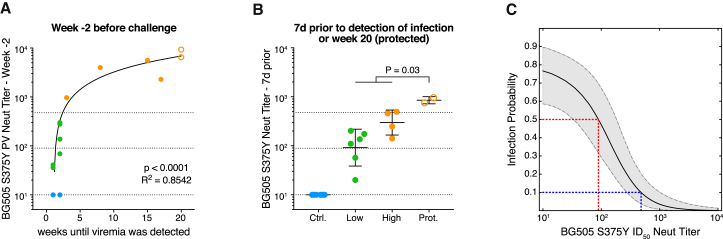
Protection Is Associated with Serum nAb Titers Greater than ∼1:500(A) Correlation of BG505 S375Y pseudovirus ID50 nAb titers at week −2 with the number of weeks until viremia was detected.(B) BG505 S375Y pseudovirus ID50 nAb titers of control (Ctrl.), low nAb titer (Low), and high nAb titer (High) animals 7 days before detection of viral load in the blood and at week 20 for protected (Prot.) animals that showed sterilizing protection throughout the study. All nAb titers were measured in TZM-bl assays. Shown are geometric mean titers with geometric standard deviations. Correlations were calculated using Spearman correlation tests, comparisons between groups were calculated using Mann-Whitney U tests. Horizontal lines indicate 50% and 90% protective nAb titers as defined in (C).(C) The 5%, median, and 95% credible intervals (CI) are shown for the probability of infection in relation to serum BG505 S375Y pseudovirus nAb titer, inferred using a modified Bayesian logistic regression model (see Figure S5). The posterior median infection probability at the limit of nAb titer detection was 77%, corresponding to an AID77. A median infection probability of 50% is attained with an ID50 titer of 1:90 (red line, CI: 34-178), and an infection probability of 10% with an ID50 titer of 1:476 (blue line, CI: 272-991).See also Figures S4 and S5.